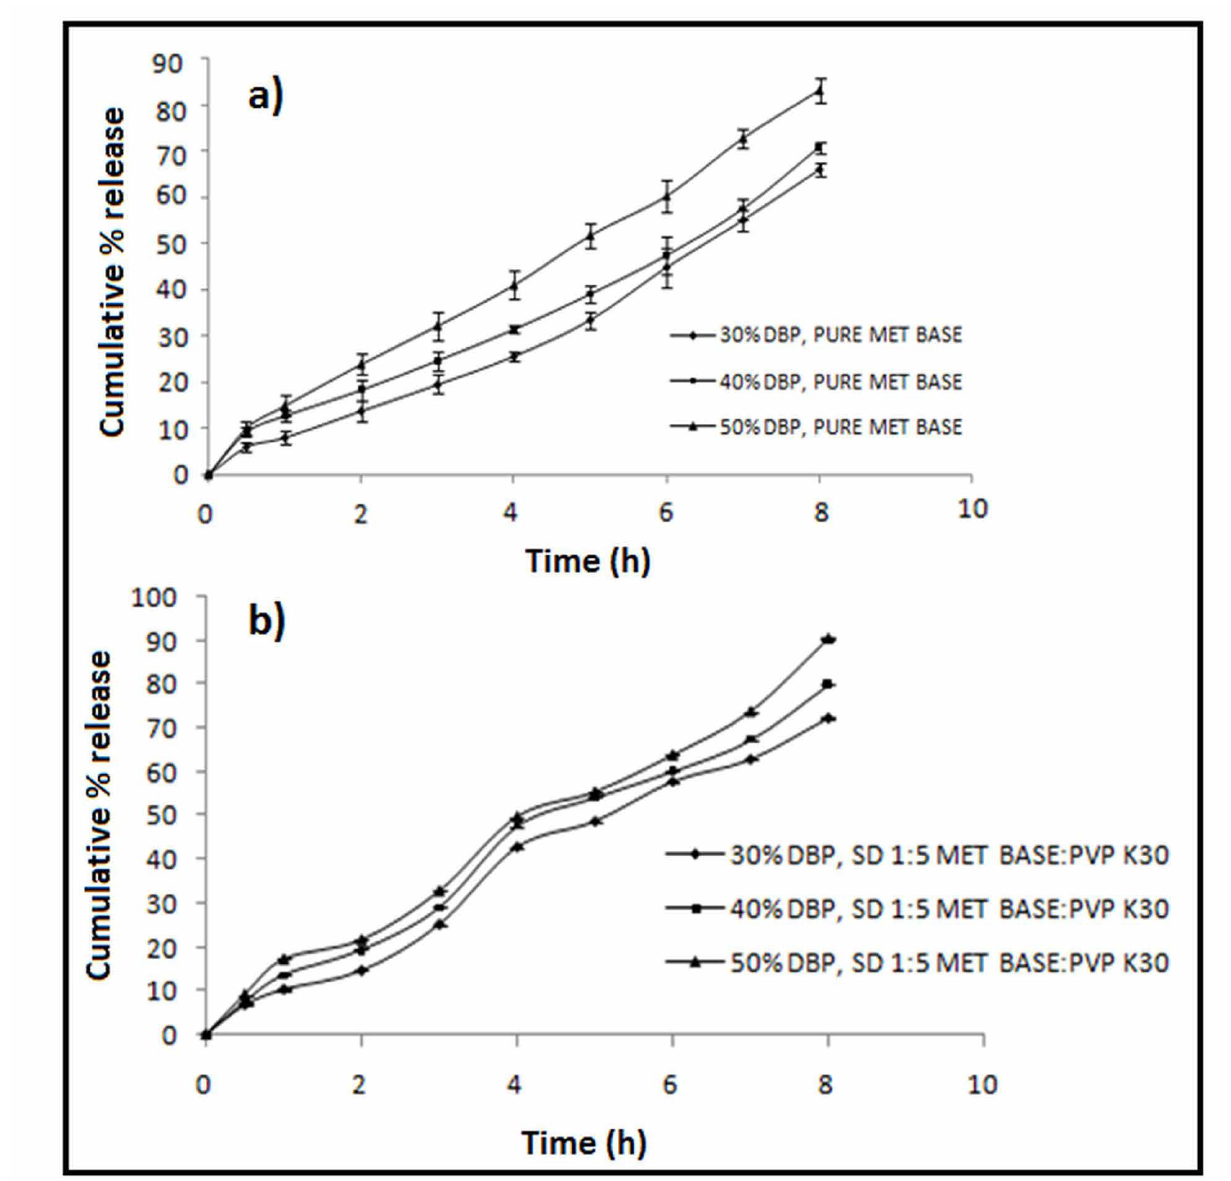
FIGURE 3 – In vitro diffusion study of pure Met base (a) and PVP K30-Met base 5:1 SD loaded patches